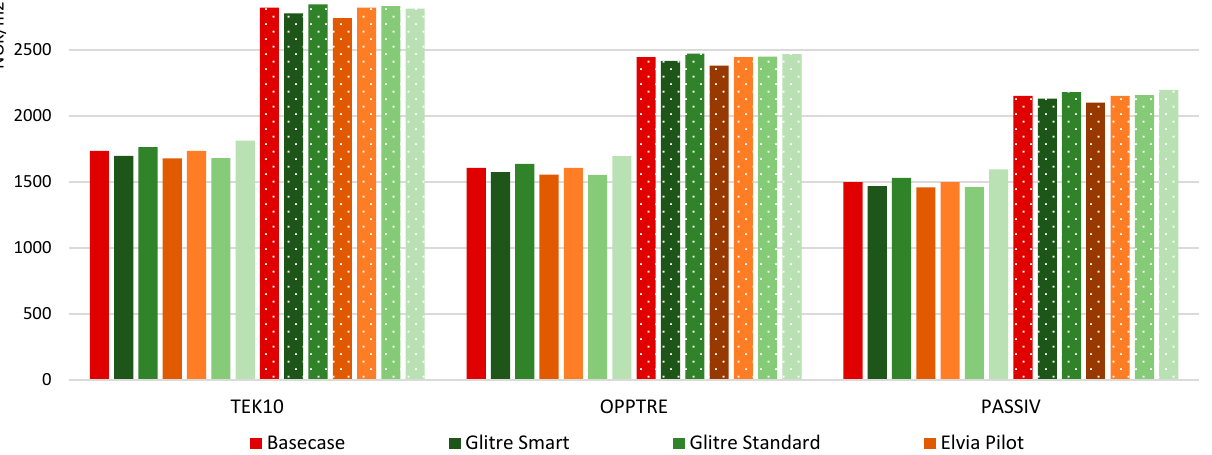
Figure 11. Total specific energy costs for Kristiansand house over 20 years for different electricity tariffs: GSHP in solid columns and A2A in shaded columns.